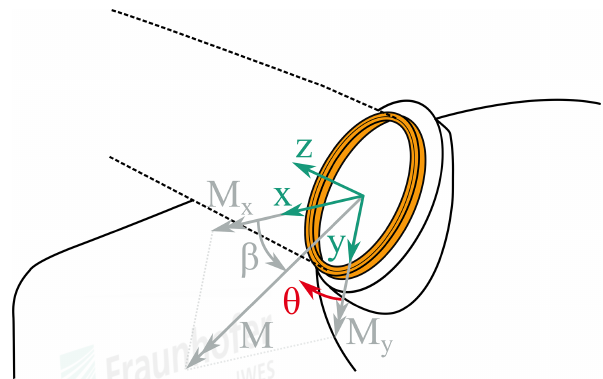
Figure 4. Coordinate system and angle definitions.